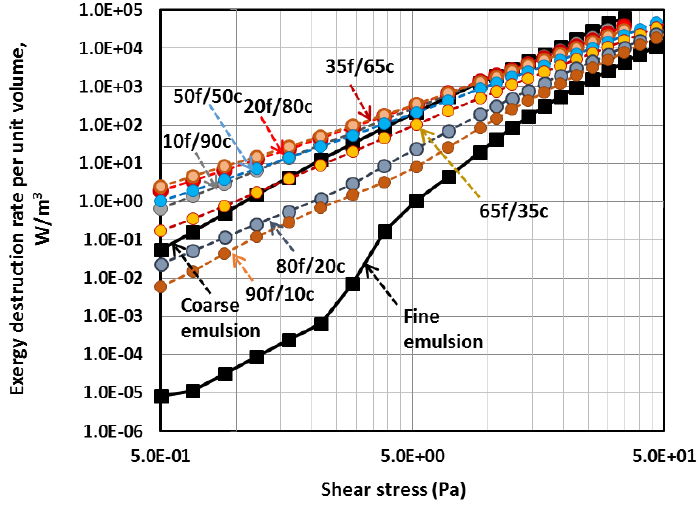
Figure 7. Exergy destruction rate versus shear stress for mixtures of fine and coarse O/W emulsions.